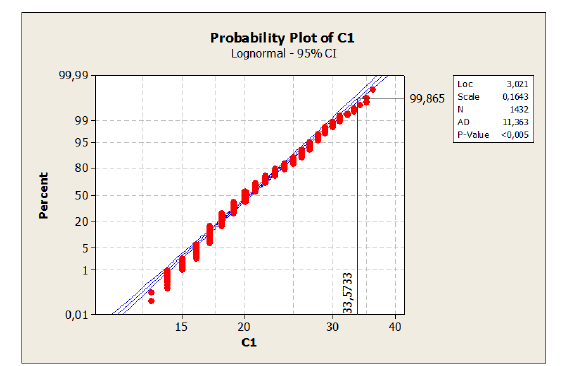
Fig. 8. Value corresponding to the 99,865% percentile of the distribution.